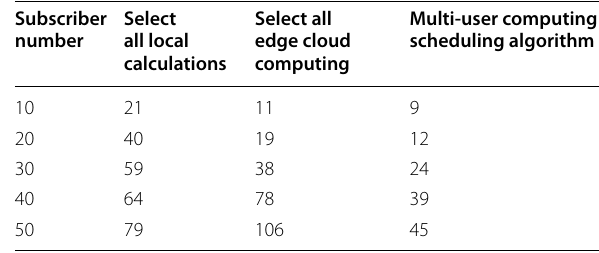
Table 2 Algorithm comparison of effective edge users Table 3 Algorithm comparison of total system